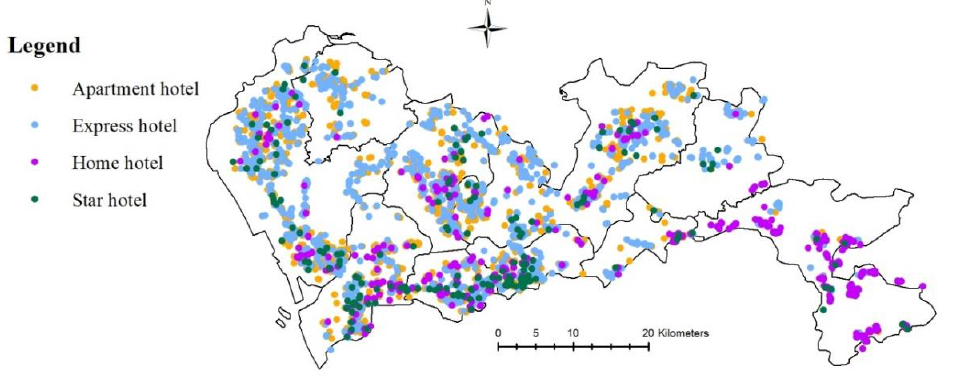
Figure 2. Distribution of POI for hotels.